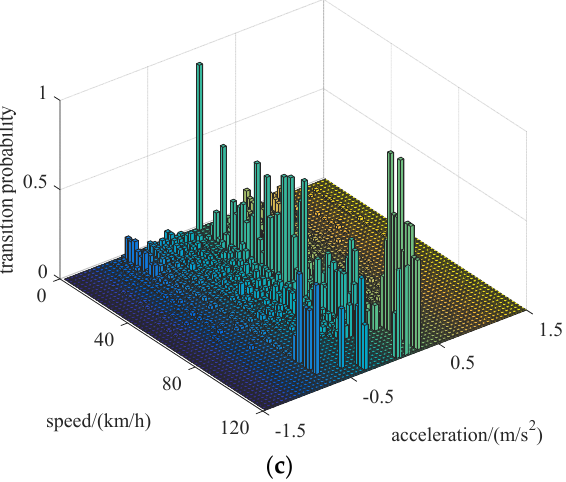
Figure 2. State transition probability matrix. ( a ) urban condition; ( b ) highway condition; ( c ) mixed condition.